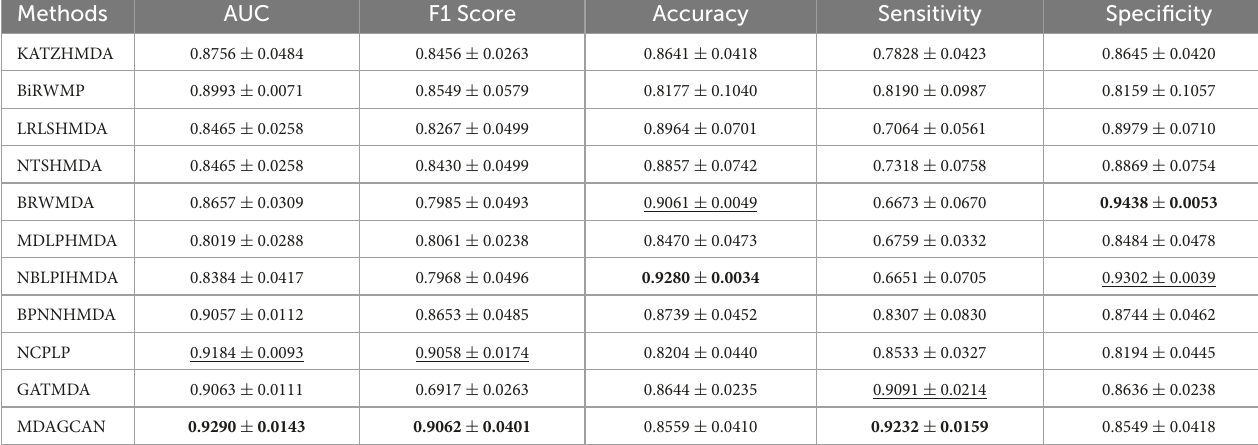
TABLE 3 Performance comparison between 10 baseline methods and MDAGCAN under vertical test for microbes in 5-fold CV on HMDAD